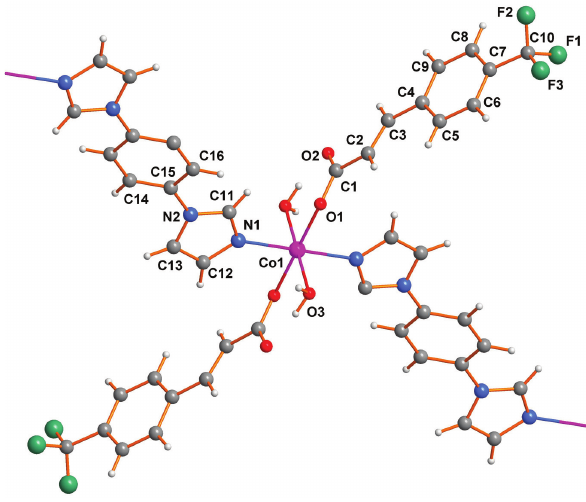
Table 1: Data collection and handling.